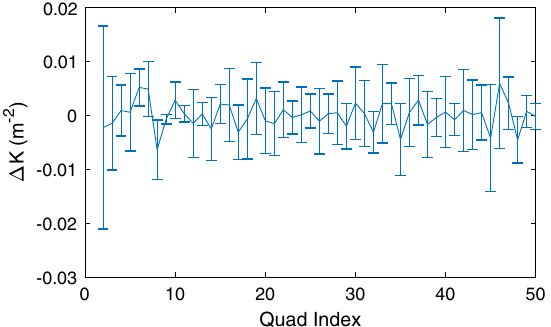
FIG. 16. Differences between the fitted quadrupole gradients and the target gradients in the L3 Linac simulation. Error bars are the standard deviation of fitting results from 10 random